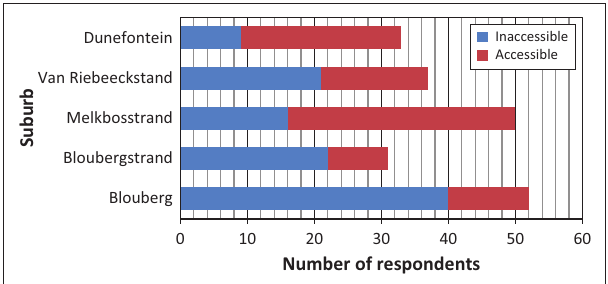
FIGURE 7: Respondents’ self-rating of their perception of safety residing in the Formal Emergency Planning Zone.